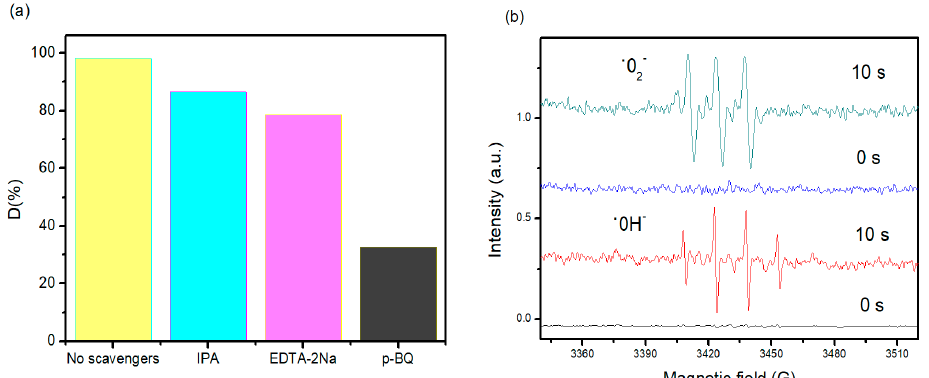
Figure 8. ( a ) Trapping experiment of the active species during photocatalytic degradation of MB